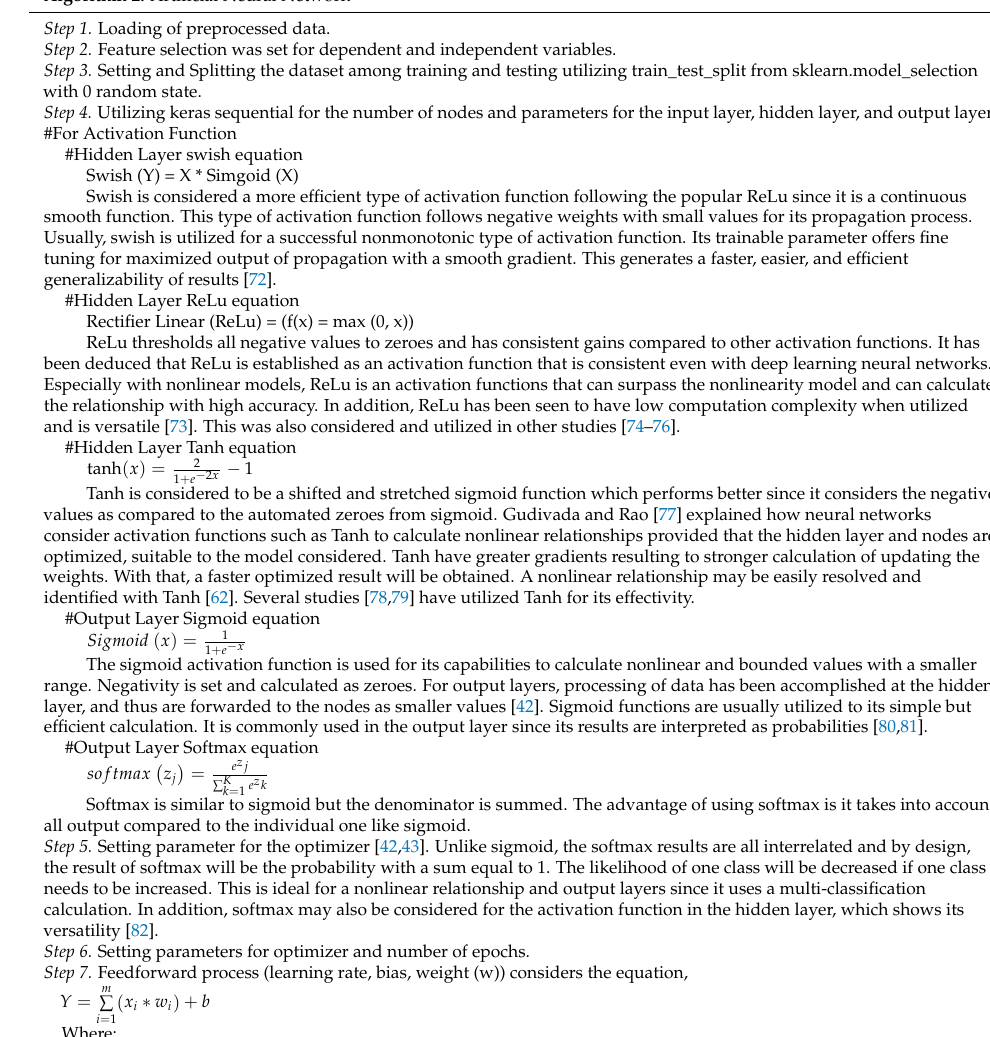
Algorithm 2: Artificial Neural